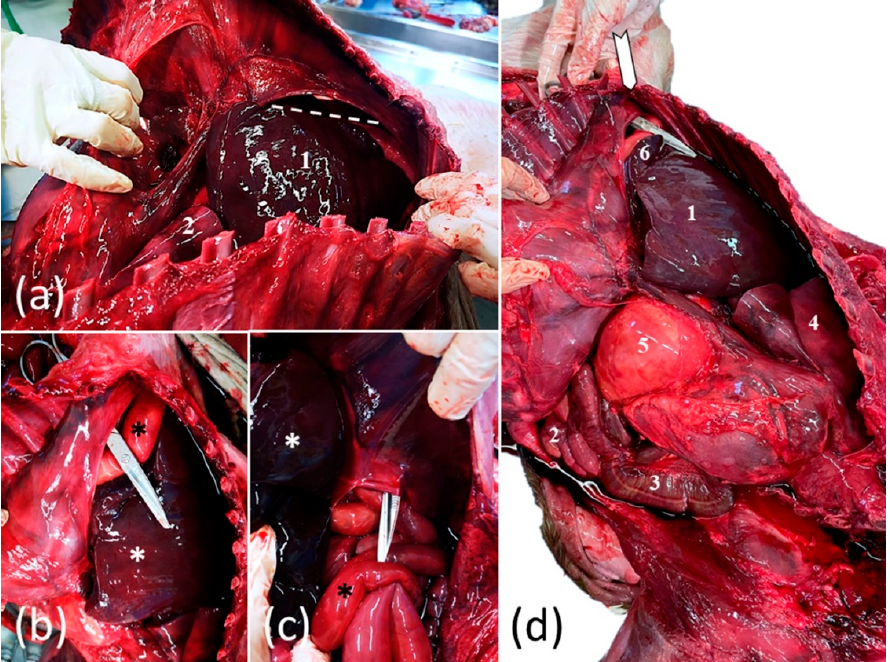
Figure 4. Foal’s congenital pleuroperitoneal diaphragmatic hernia: ( a ) cranial view of the thoracic cavity after removal of the left thoracic wall; the thoracically translocated parts of the liver (1), the diaphragm and the area of the dorsal diaphragmatic defect (dotted accolade) and hypoplastic left lung (2); ( b , c ) caudal view of the large diaphragmatic defect with round and bold margins (indicated by surgical scissors) which allowed partial migration of the liver (white *) and bowel (black *) from the abdomen into the thorax; ( d ) lateral view of the coelomic cavity after removal of the thoracic wall; the thoracically translocated parts of the liver (1); the ventral (2) and the dorsal (3) loop of the left ascending colon; the diaphragm and the area of the dorsal diaphragmatic defect (white arrow); the lung (4) the stomach (5) and the spleen (6).